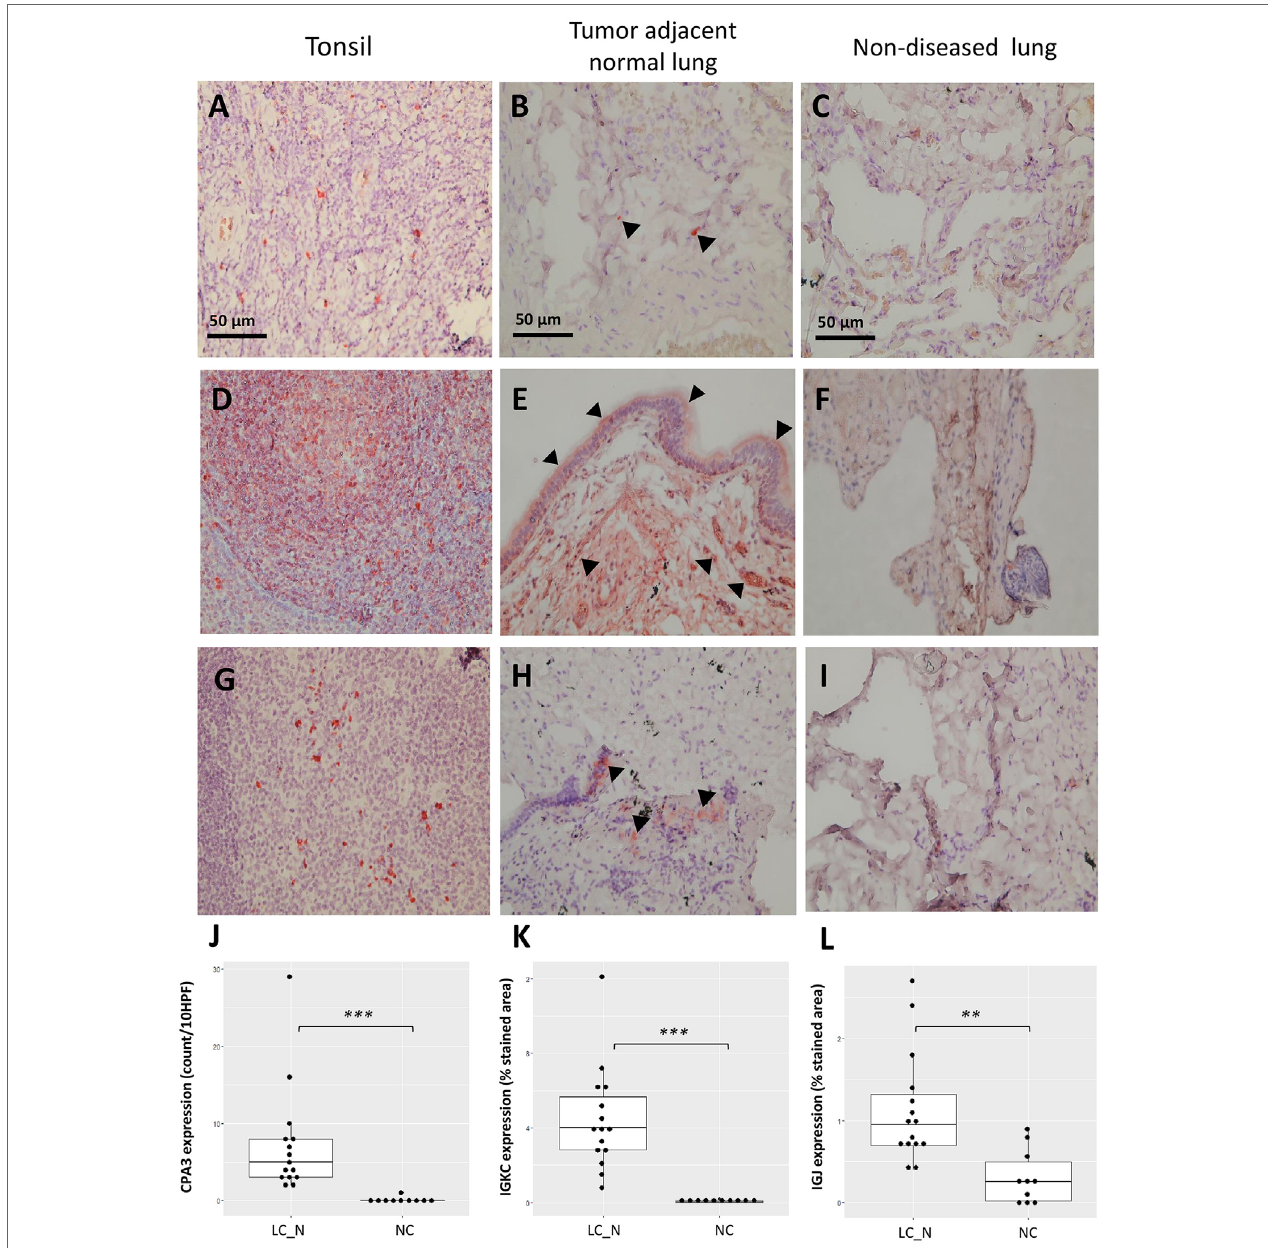
FigUre 7 | Representative immunohistochemistry staining of CPA3 (a–c) , IGKC (D–F) , and IGJ (g–i) from the positive control tonsil tissue, tumor adjacent normal lung tissue, and non-diseased lung tissue under 400 × high power magnification, respectively. Increased staining of each protein was noted in the matrix of tumor adjacent normal lung tissue [arrowhead (B,e,h) ]. Quantitative analysis of the expression of CPA3 (J) , IGKC (K) , and IGJ (l) between tumor adjacent normal lung tissue (LC_N, n = 15) and non-diseased lung tissue (normal controls, n = 10). *** p < 0.001 and ** p < 0.01 by Wilcoxon signed-ranked test, HPF, high power